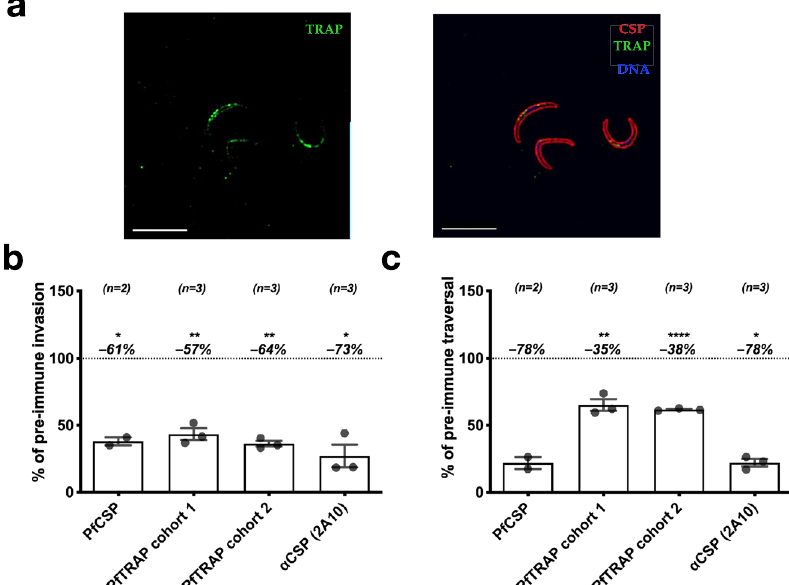
Fig. 4 Polyclonal antibodies to PfTRAP inhibit parasite invasion and traversal in vitro. Mice were immunized three times with PfTRAP or PfCSP ectodomains. a Immune sera were used to verify binding to Pf sporozoites via immuno fl uorescence. Shown are fi xed, permeabilized sporozoites labeled with a 1:800 dilution of polyclonal anti-PfTRAP mouse serum (followed by anti-mouse IgG secondary; green channel), fl uorescently labeled anti-PfCSP monoclonal antibody 2A10 (red channel, right image) and DAPI nuclear stain (blue channel, right image); 10-µm scale bars are shown. Immune serum was then assessed for function in vitro for inhibition of invasion ( b ) and traversal ( c ). In b and c , each data point is the average “ % of pre-immune ” invasion or traversal from technical triplicates in independent experiments; two separate immunization experiment sets are represented as “ PfTRAP cohort 1 ” and “ PfTRAP cohort 2 ” . Each bar indicates the group mean, with error bars representing standard error of the mean and percent change from 100% (shown as dashed line) shown above. Asterisks indicate a signi fi cant difference from 100% as determined by a two-tailed one-sample t -test where * is p ≤ 0.05; ** is p ≤ 0.01; and **** is p ≤